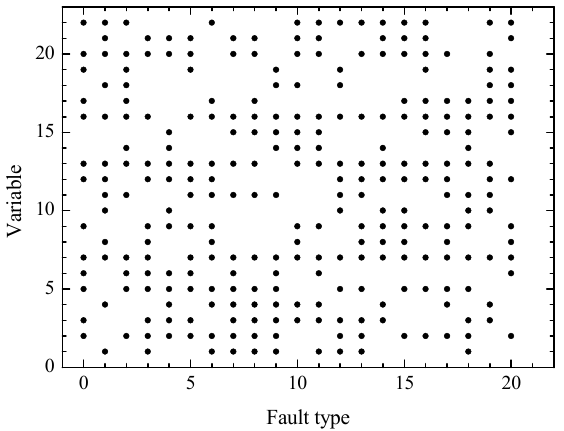
Figure 7. Key variables selected for each of the 20 TE faults.